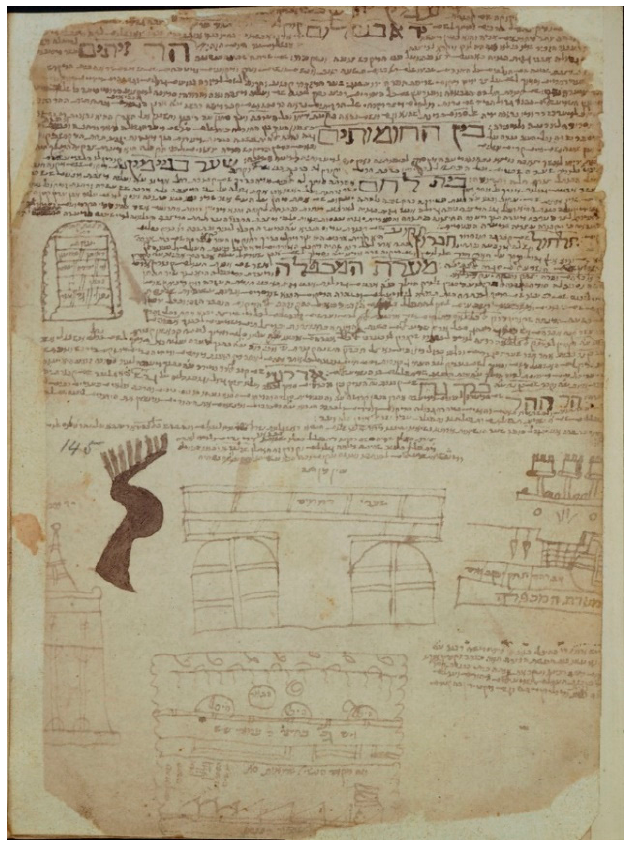
Figure 3. London, The British Library Add. 27,125 f145a. The List of Yitgaddal, early 14th century, used with permission © British Library Board.